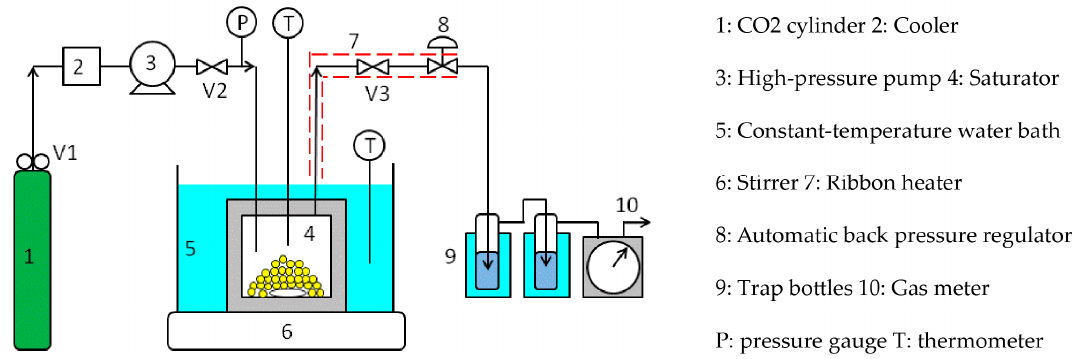
Figure 2. Flow-type apparatus used for the silicone resin solubility measurements.